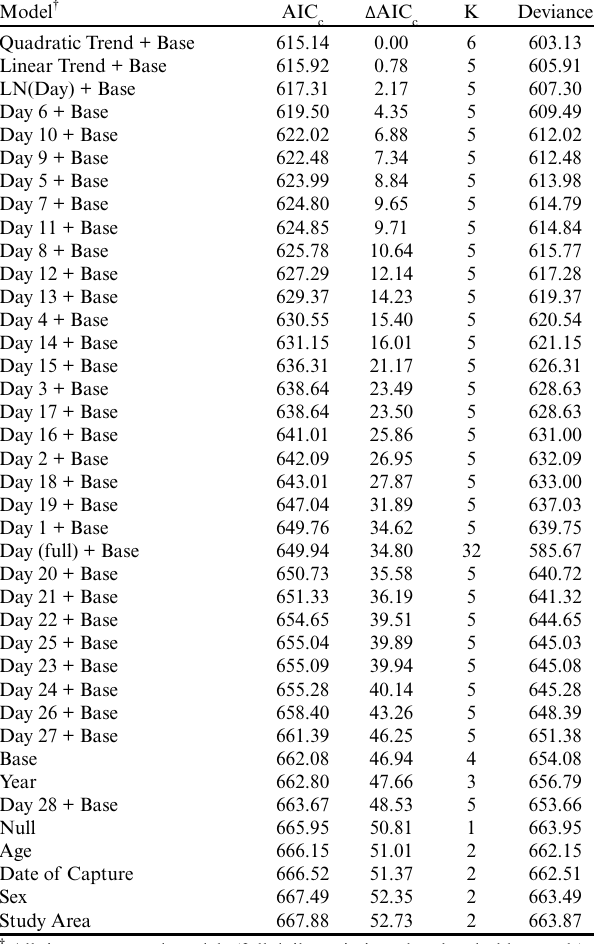
† All time-structured models (full daily variation, day thresholds, trends)